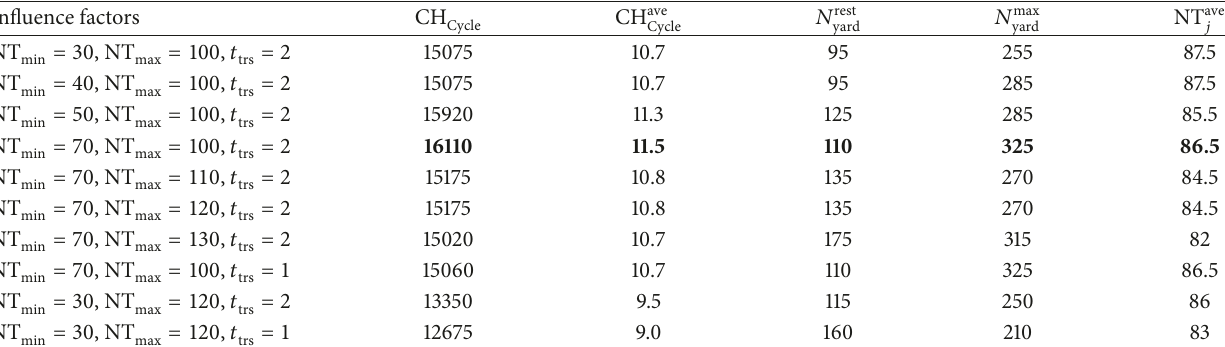
Table 4: Influence factors analysis of 15 container